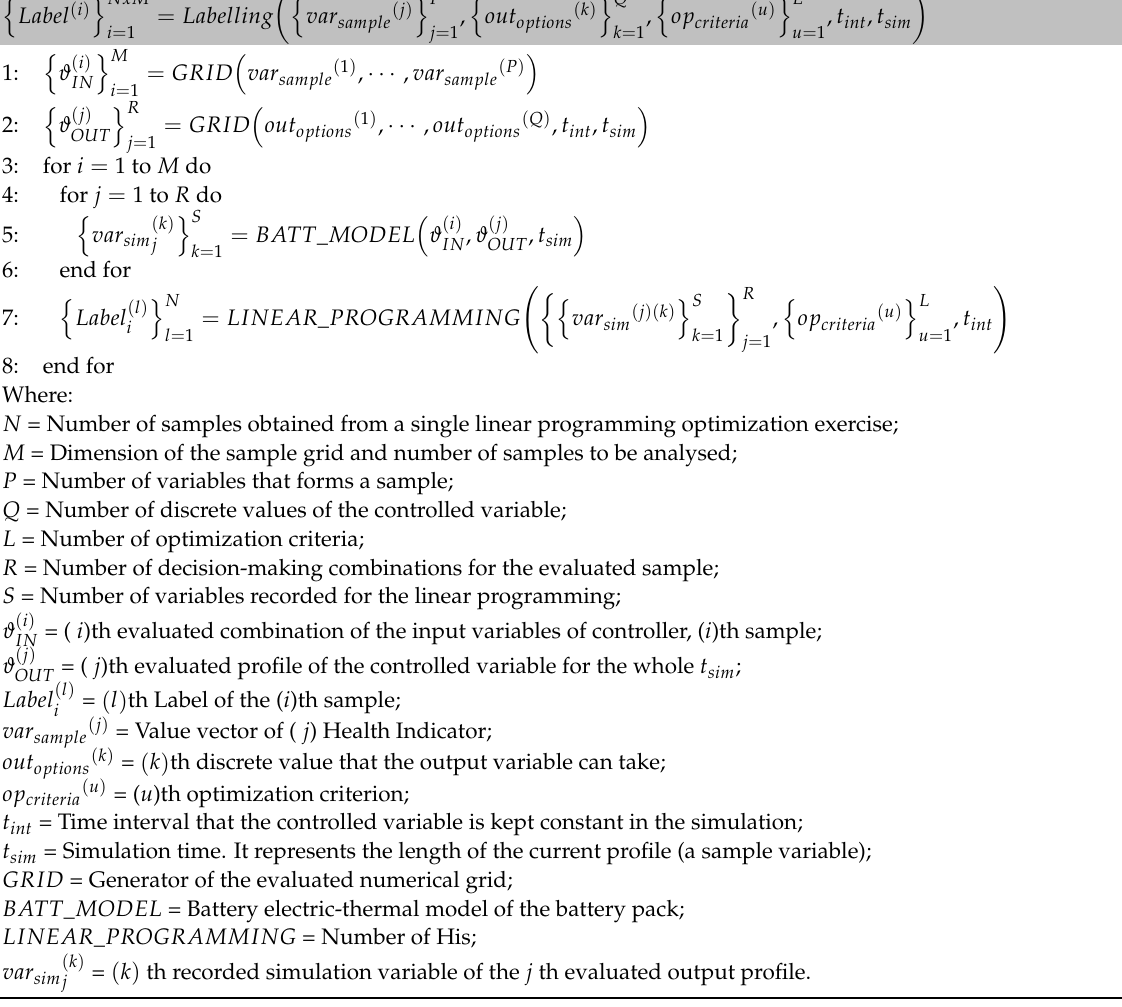
Algorithm 1. Pseudo-code of the labelling